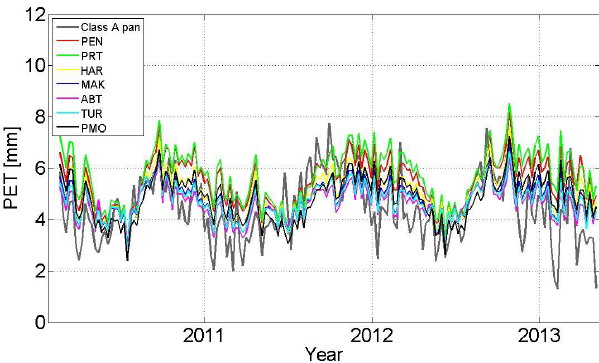
Figure 3: Comparison of PET models with class A pan recordings on a weekly mean basis 3 Figure 3. Comparison of PET models with class A pan recordings (February 2010 - April 2013) 4